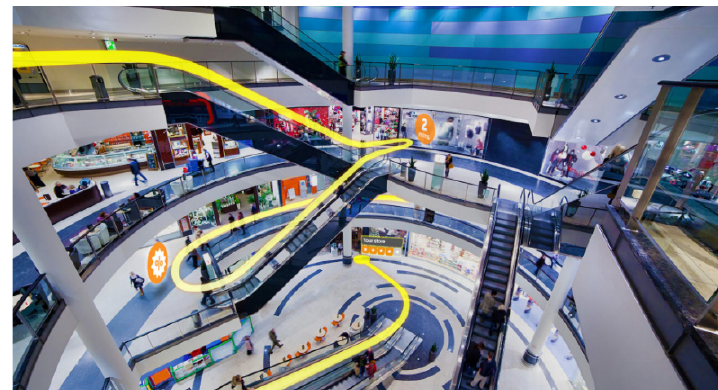
Fig. 2. The example of AR geovisualization of the route in the building (source: Blippar launches indoor visual positioning system [...],